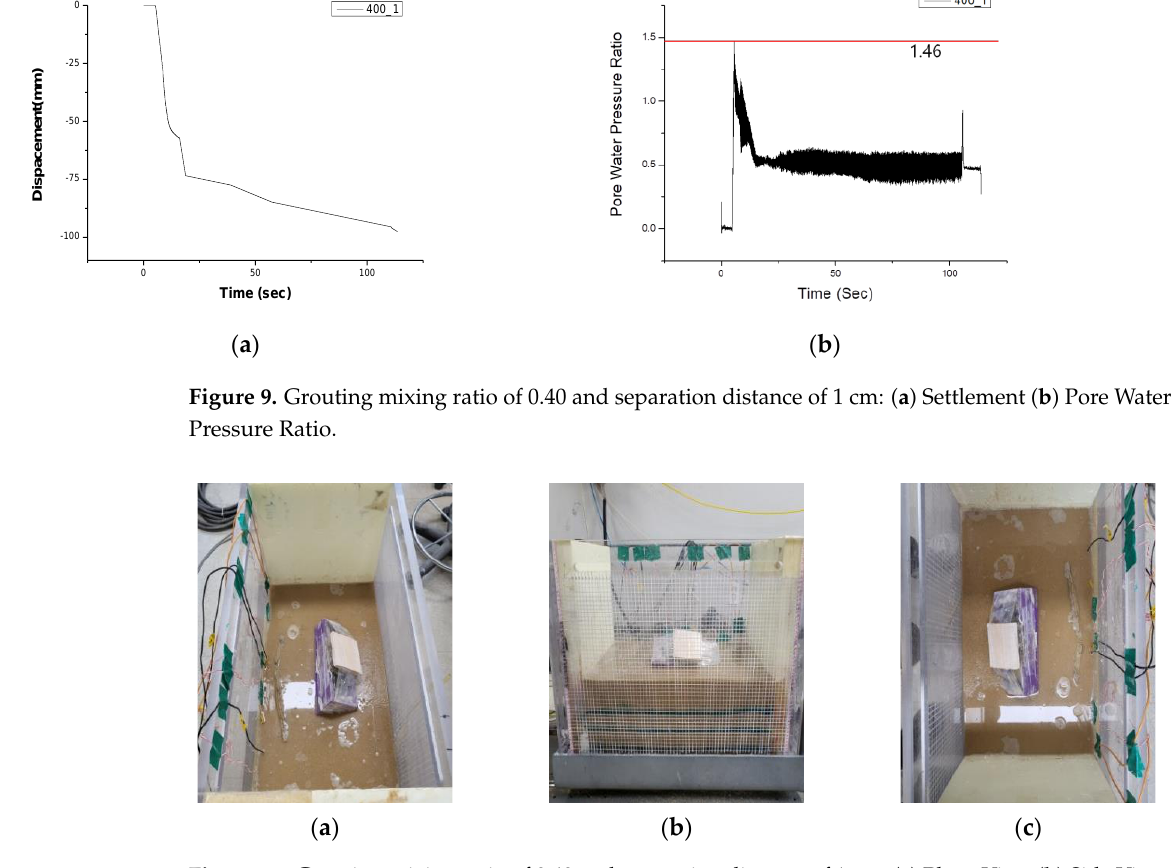
Figure 10. Grouting mixing ratio of 0.40 and separation distance of 1 cm: ( a ) Plane View ( b ) Side View.